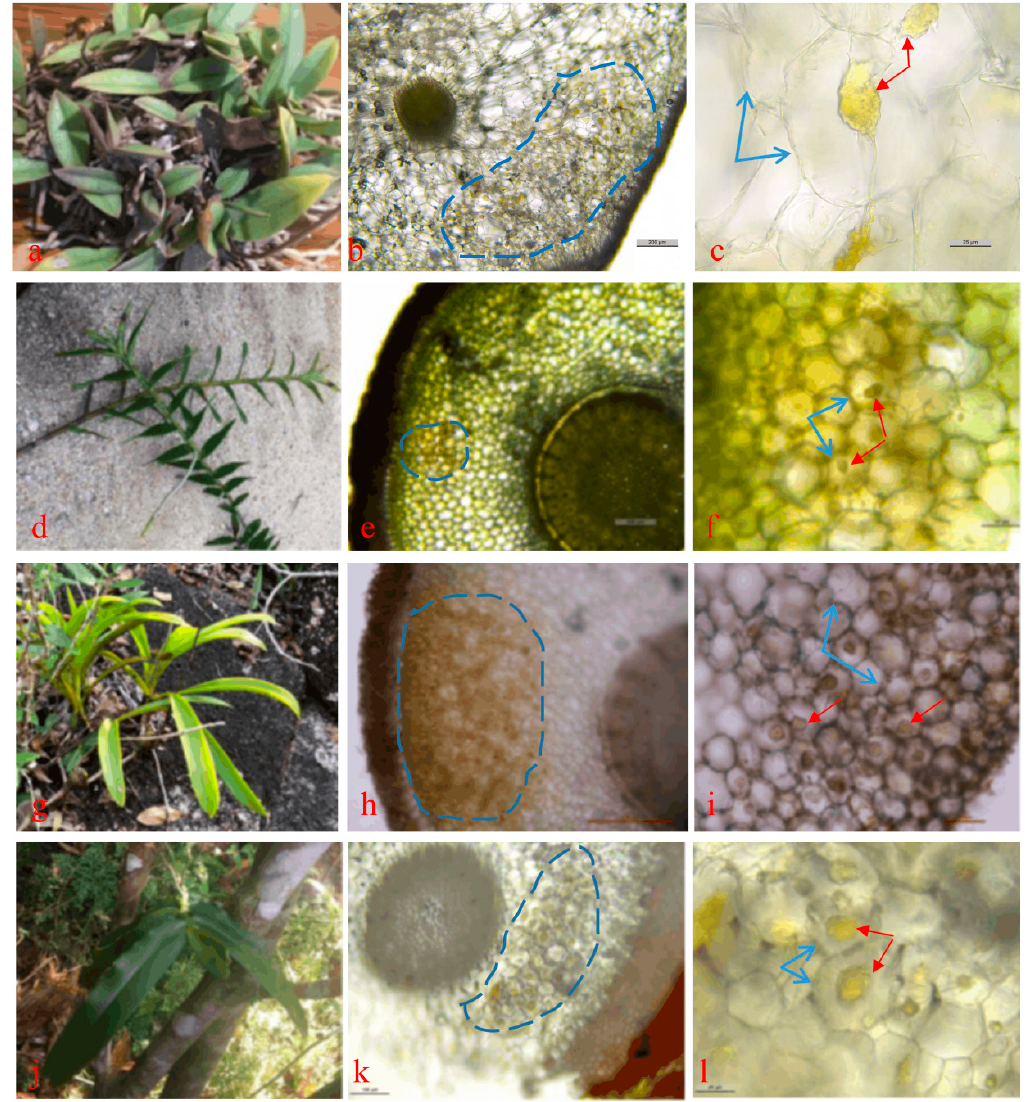
Figure 1. The wild plants and intracellular fungal pelotons in the roots of four orchid species. Photographs of the plants and fungal pelotons are shown for Doritis pulcherrima ( a – c ), Acampe rigida ( d – f ), Renanthera coccinea ( g – i ), and Robiquetia succisa ( j – l ) plants from Jianfengling National Nature Reserve of Hainan in China. The blue dotted boxes indicate the areas containing the intracellular fungal pelotons. The blue arrows indicate the cell walls of the orchid roots. The red arrows indicate the intracellular fungal pelotons of the orchid roots.